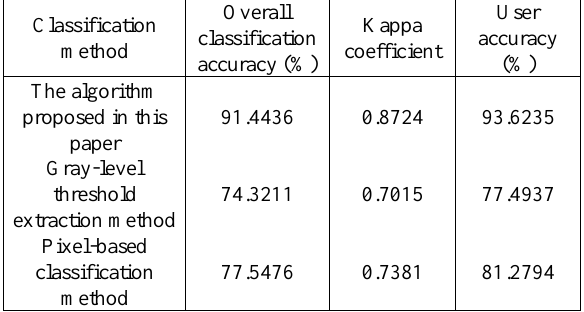
pixel-based classification method are shown in Table 1.